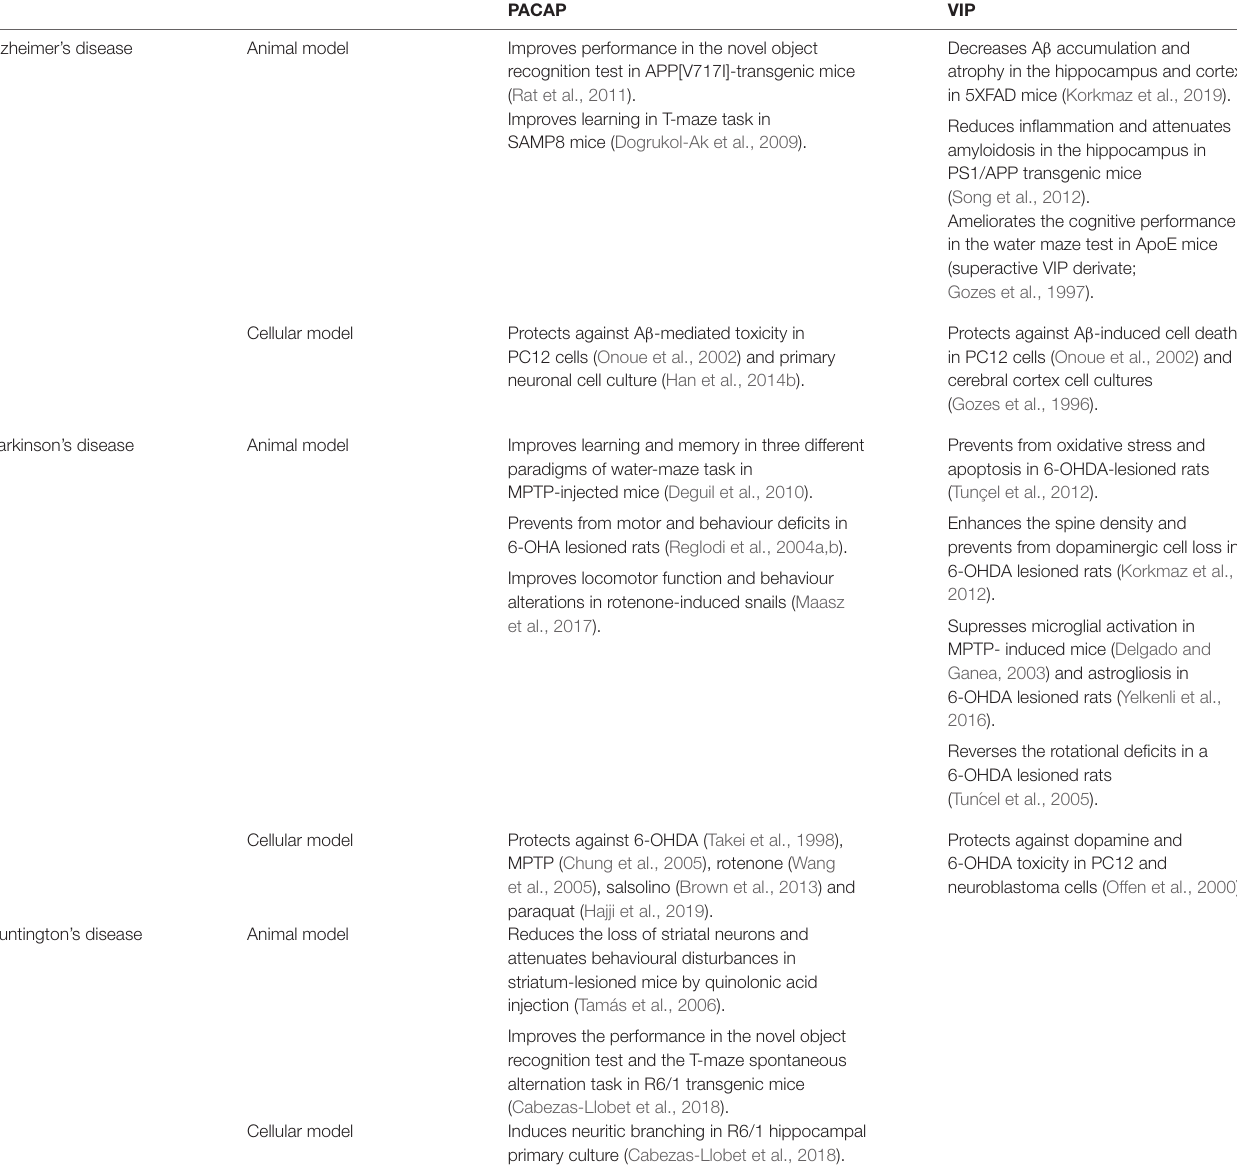
TABLE 1 | Beneficial effects of pituitary adenylate cyclase-activating polypeptide (PACAP) and vasoactive intestinal peptide (VIP) in cellular and animal models of different neurodegenerative